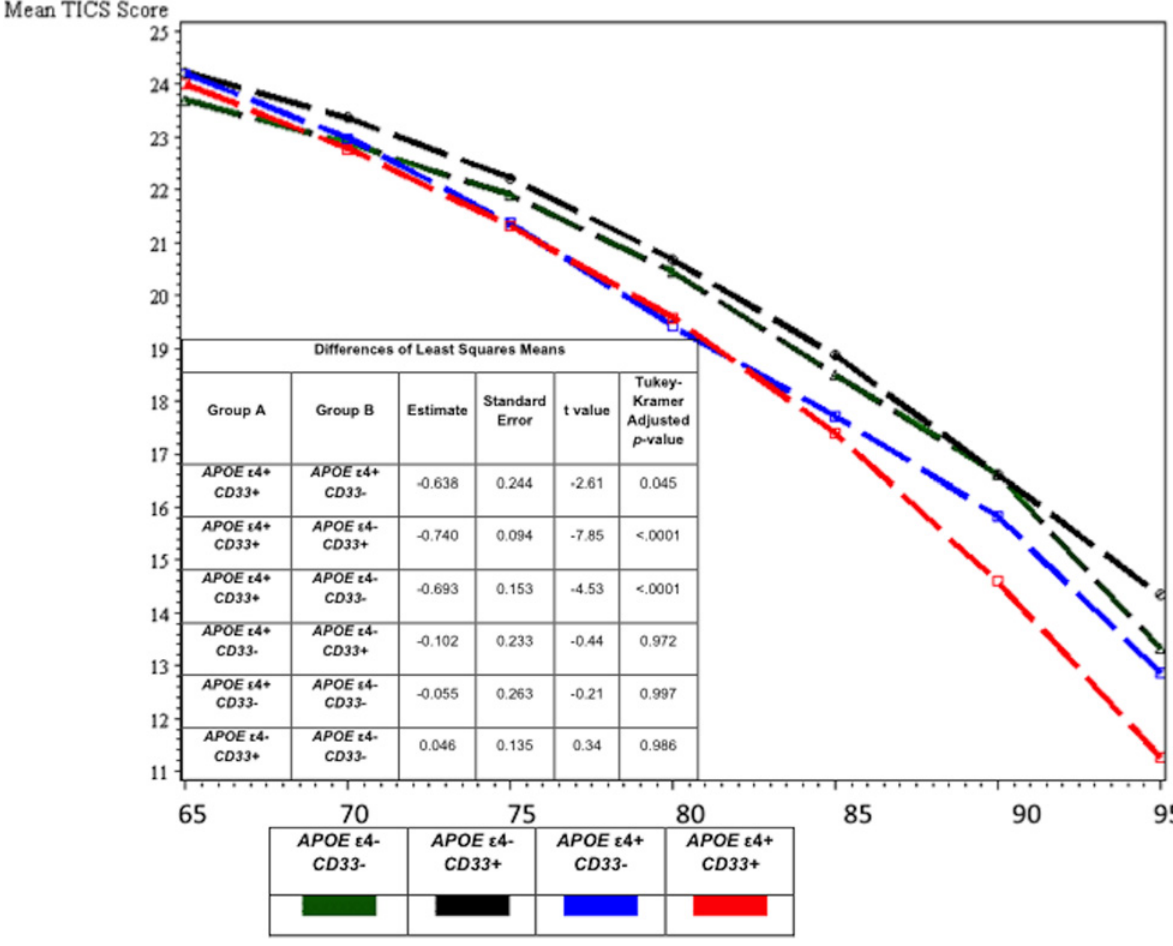
Fig 3. Mixed effects models for cognitive trajectories by APOE ε 4/ CD33 risk group. Abbreviations: TICS-m: Telephone interview for Cognitive Status- modified. Covariates included age, age 2 , sex, sex * age, education, education * age, group, and group * age.